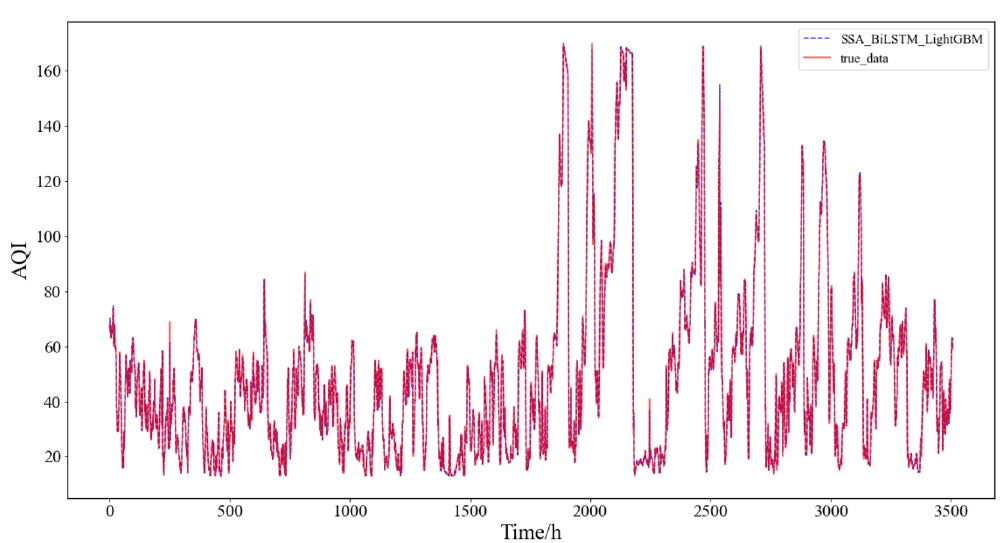
Figure 9. SSA-BiLSTM-LightGBM prediction